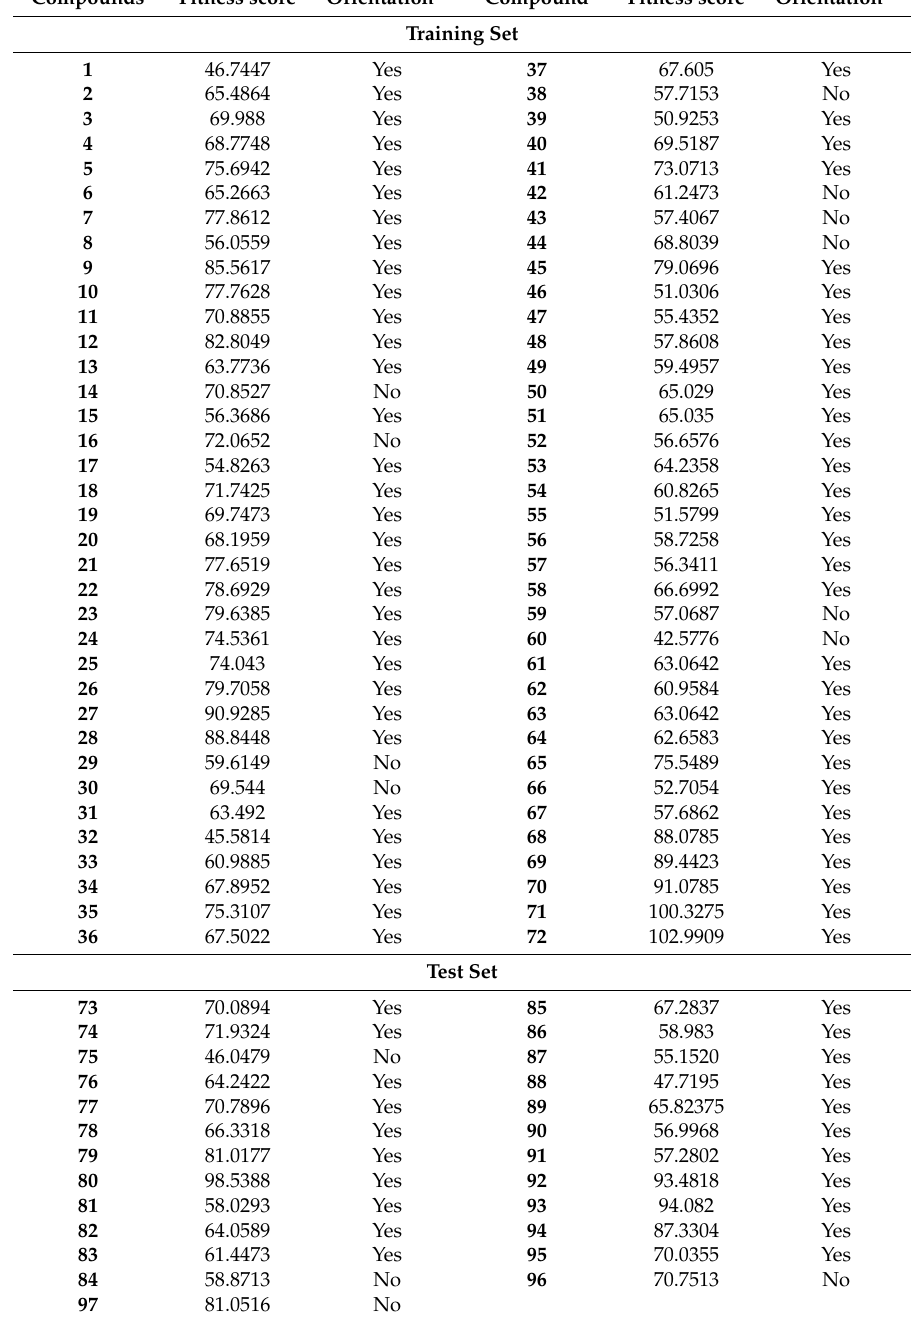
Table 4. The docking results of the 97 compounds in the training and test sets. Compounds Fitness score Orientation